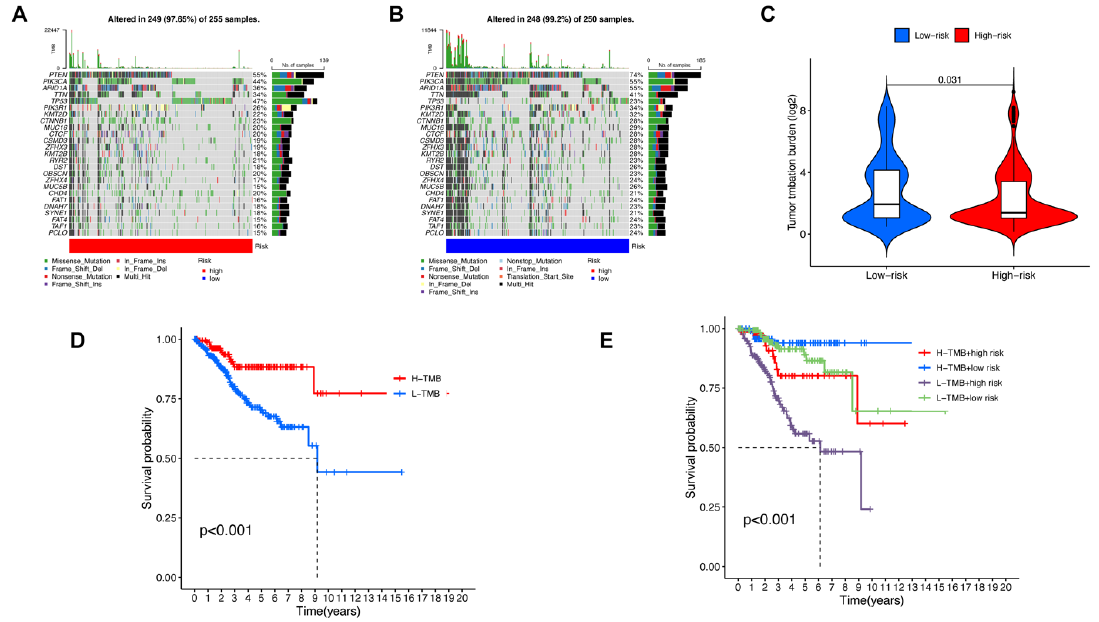
Figure 7. Somatic mutation analysis and TMB correlated analysis. ( A ) The waterfall chart of the top 25 most frequently mutated genes in the high-risk group. ( B ) The waterfall chart of the top 25 most frequently mutated genes in the low-risk group. ( C ) TMB in low-risk and high-risk groups. ( D ) Kaplan–Meier curves of OS in high-TMB and low-TMB groups. ( E ) Kaplan–Meier curves of OS in groups with various TMB and risk